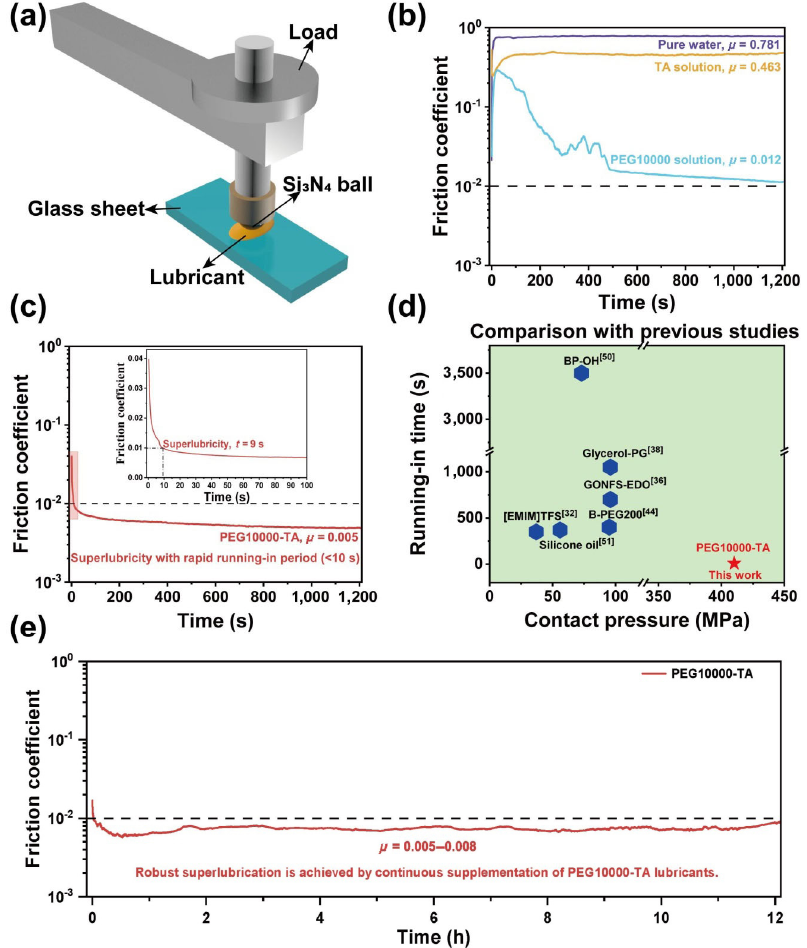
Fig. 2 (a) Schematic of tribological experimental testing equipment. (b) Friction coefficient of pure water, TA aqueous solution (2 wt%), and PEG10000 aqueous solution (45 wt%). (c) Friction coefficient of PEG10000 (45 wt%) and TA (2 wt%) mixed aqueous solution (PEG10000-TA). The inset shows the change in the friction coefficient in the first 100 s. (d) Comparison of the running-in time and contact pressure of superlubricity in this work with previous studies. (e) Friction coefficient of PEG10000-TA, which was continuously supplemented (30 µL/h). The load applied was 4 N, the linear sliding amplitude was 2 mm, and the maximum linear velocity was 0.025